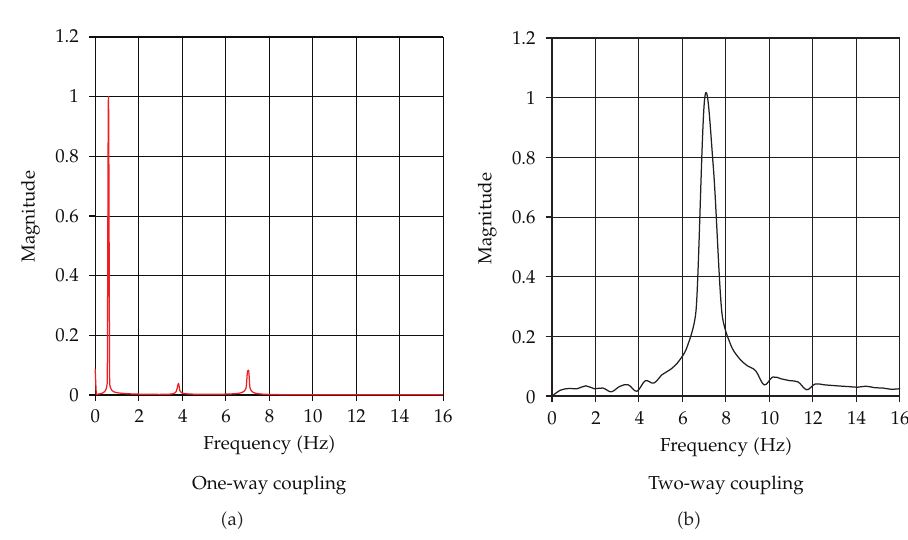
Figure 14: Frequency spectrum, v (cid:8) 0 . 64m/s, plate